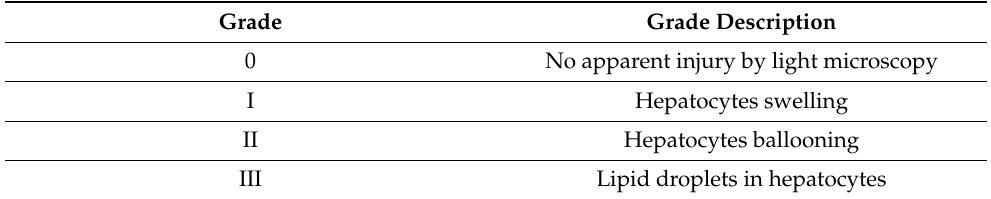
Table 1. Grading of the hepatic lesions.